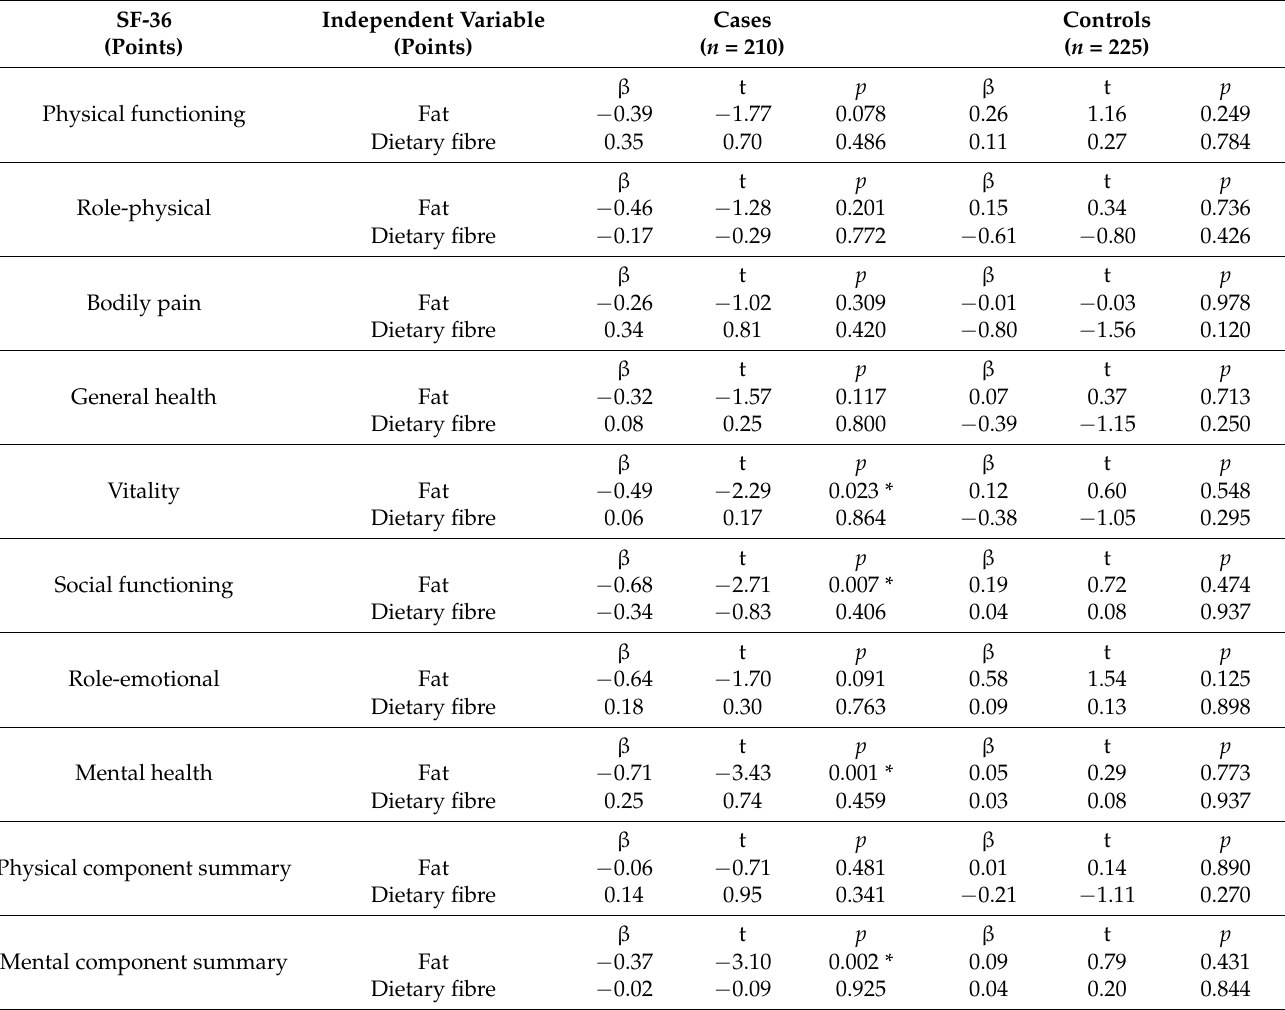
Table 4. Results of multiple regression analysis between quality of life components of the short-form health survey (SF-36) questionnaire and fat and dietary fibre